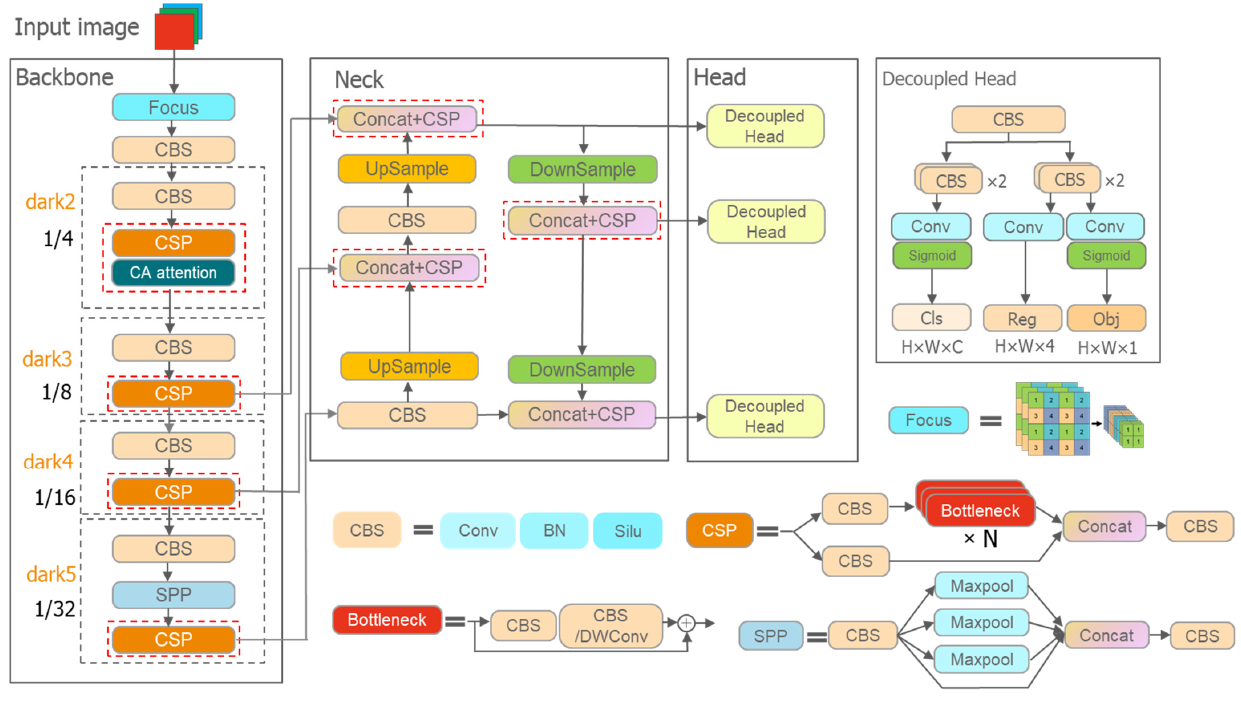
along the vertical direction; ( d ) Y average pooling: one-dimensional features are encoded along the